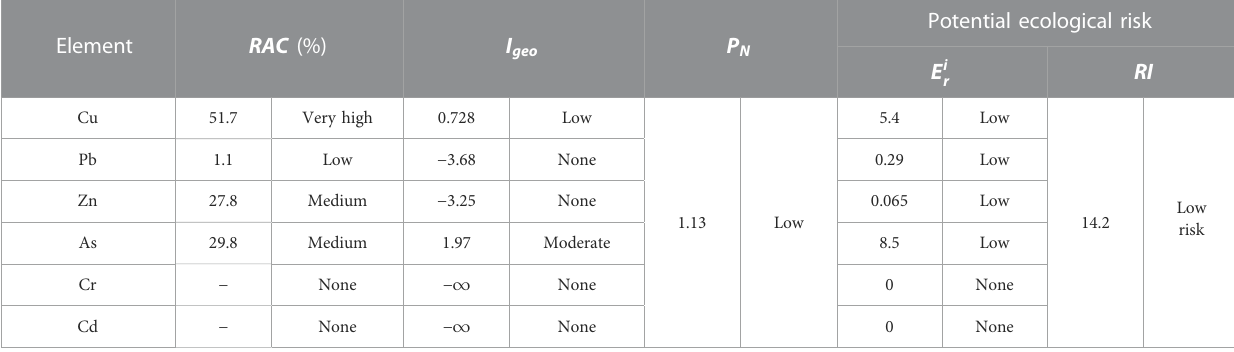
TABLE 4 The degrees of contamination and ecological risk of heavy metals in the low-grade copper sul fi de tailings.